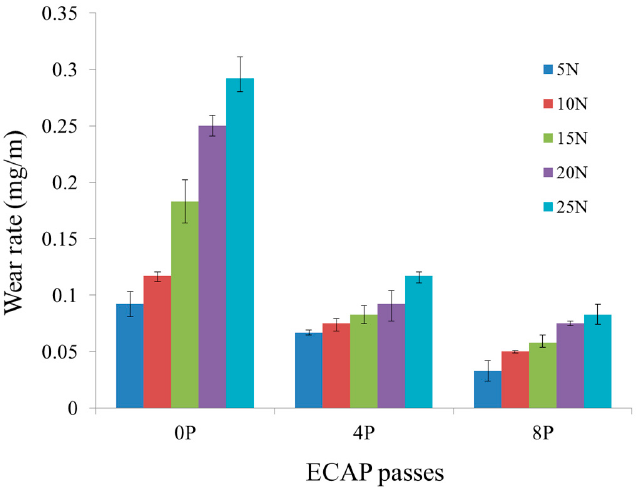
Figure 10. The wear rate of the SiC p /Al-Si composite with different ECAP passes under the dry friction condition (sliding speed is 10 mm/s; loads are 5 N, 10 N, 15 N, 20 N and 25 N). The 0p-ECAP sample corresponds to PM